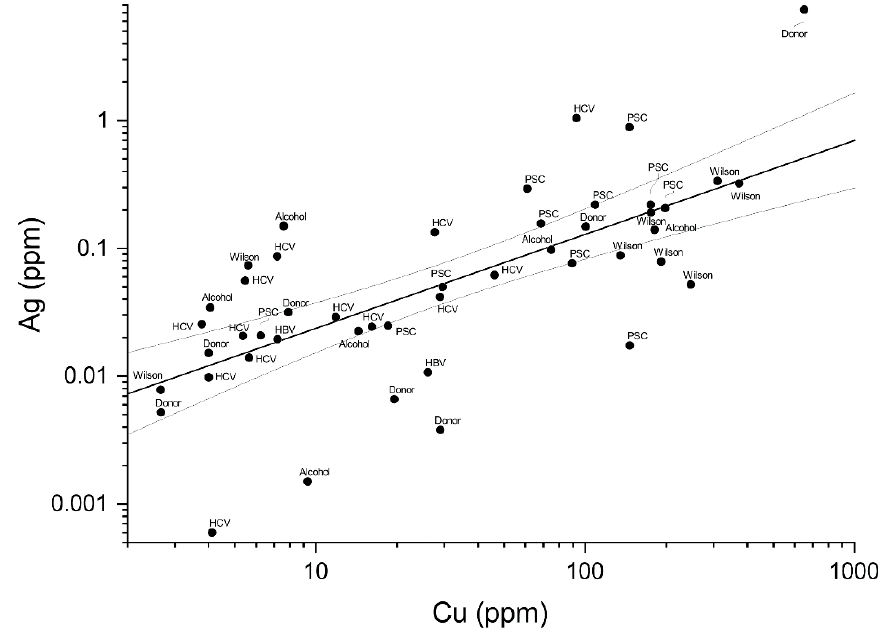
Figure 3. Correlation between silver and copper concentrations in livers of study subjects, with their disease status labeled in the plot. Individuals with silver levels below the detection limit were not included. Thick line represents the log–log correlation; thin lines denote 95% confidence bands.